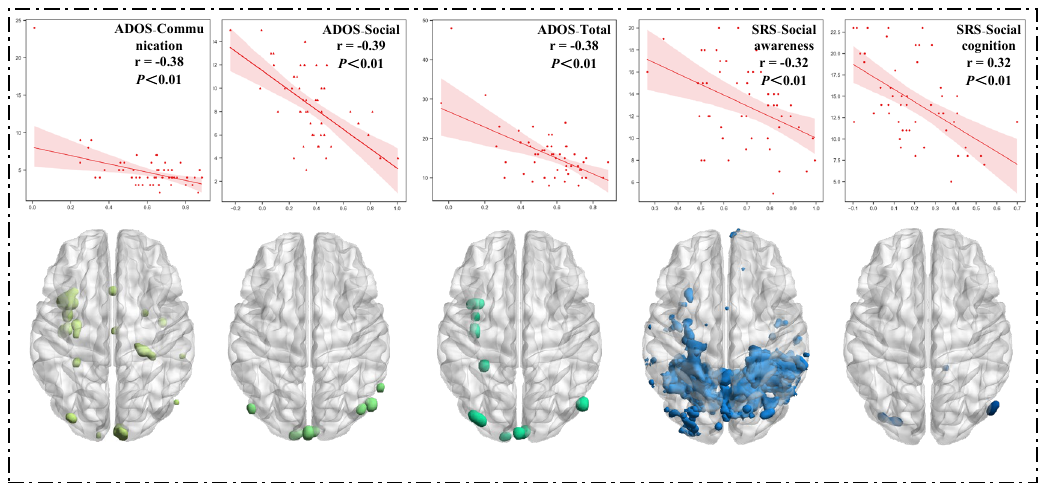
Figure 3. The correlation between clinical characteristics and functional connectivity strength.